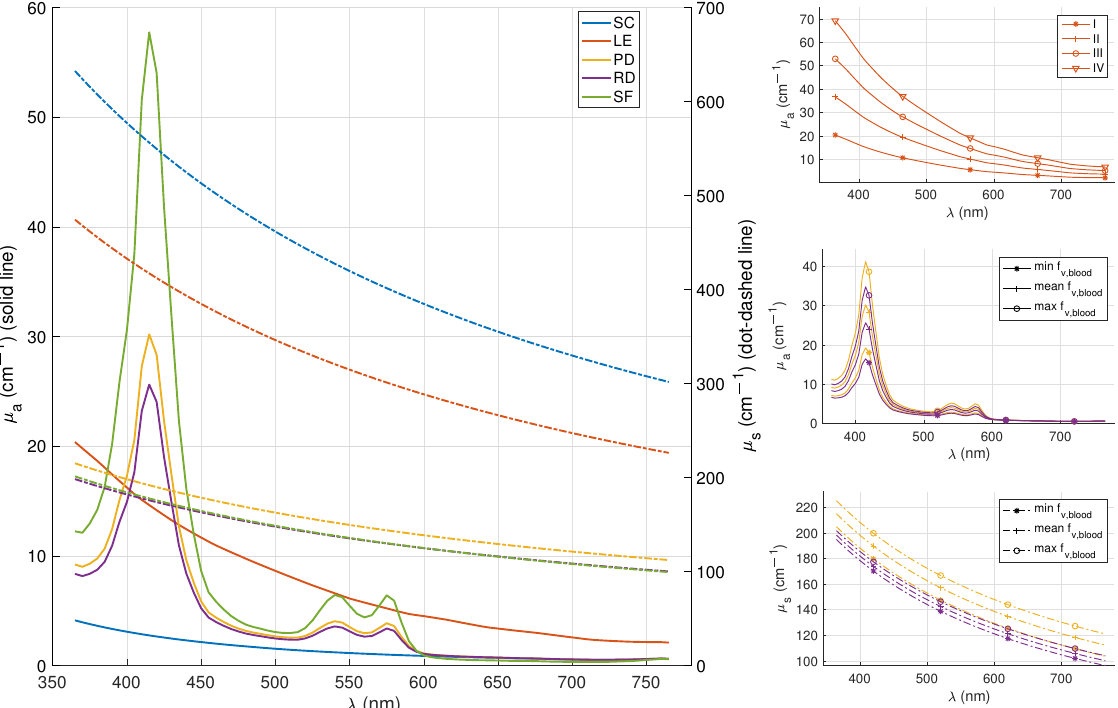
Figure 2. Absorption ( µ a solid line) and scattering ( µ s dashed-dot line) coefficients of each layer (SC, LE, PD, RD and SF in blue, red orange, violet and green, respectively) of the designed numerical medium set for skin phototype I and mean dermal blood volume fraction. The spectral curves of the LE absorption coefficient µ 2 a as a function of skin phototypes I, II, III and IV appear in the top-right subplot, while middle-right and bottom-right subplots focus on the dermal blood volume fraction impact over the PD and RD absorption coefficient µ 3 a and µ 4 a , as well as their scattering coefficient µ 3 s and µ 4 s . LE: living epidermis; SC: stratum corneum; PD: papillary dermis; RD: reticular dermis; SF: subcutaneous